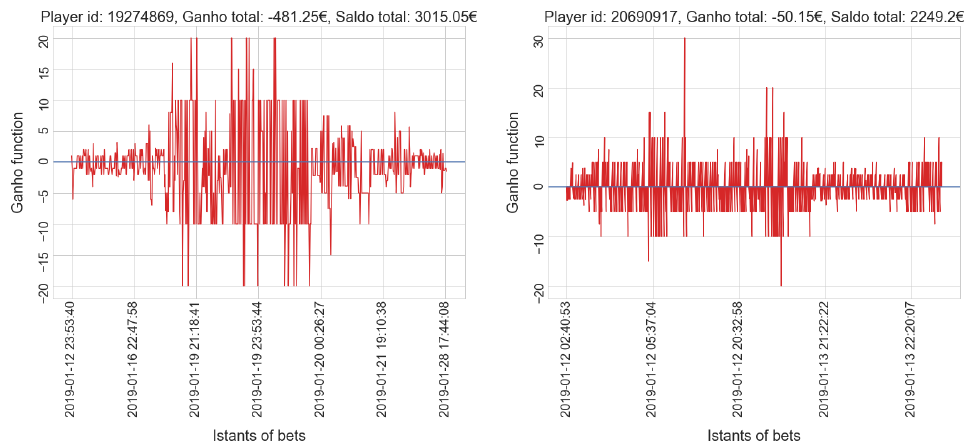
Figure 21. Time series plot of two players in Cluster